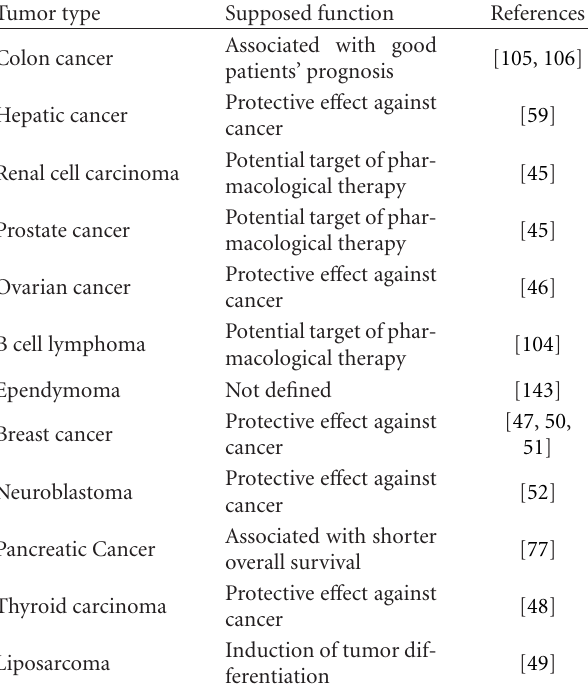
Table 1: E ff ects of PPAR γ expression/activation in di ff erent human